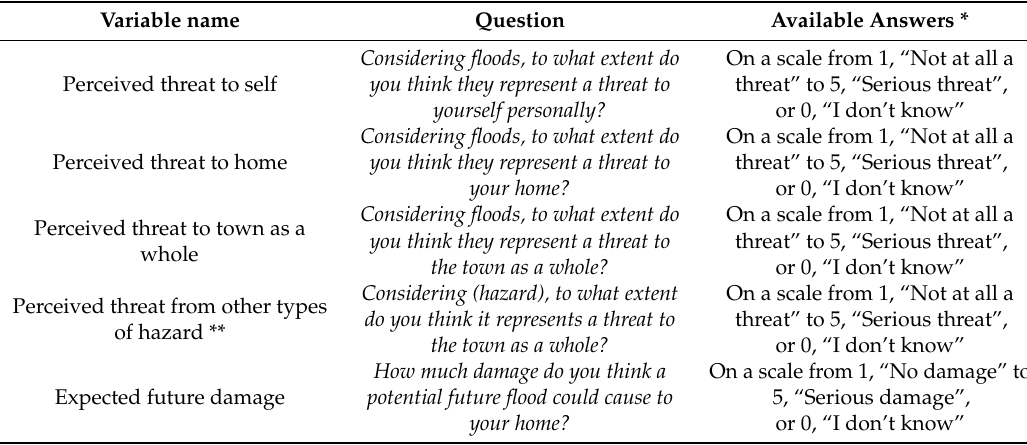
Table 2. Dependent